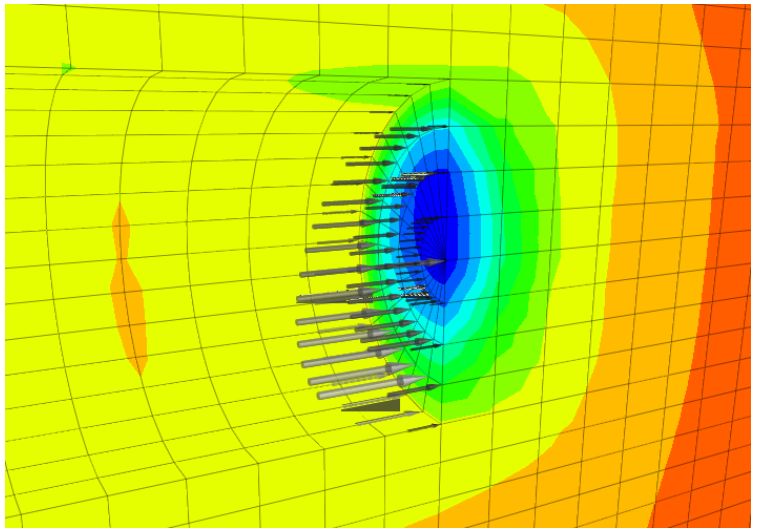
Figure 11. FLAC 3D three-dimensional model. The colours represent the randomly generated soil layers 1 (yellow), 2 (green), and 3 (orange). Units in metres.